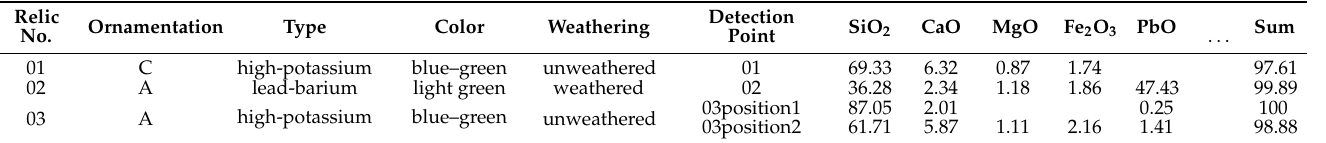
Table 1. The first three lines of the